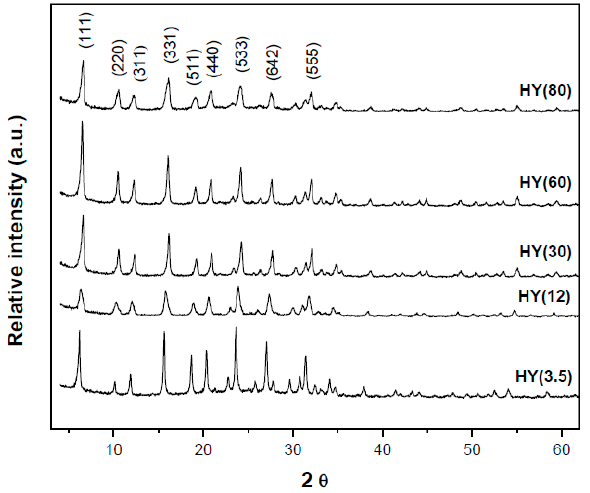
Figure 1. X-ray diffraction patterns of the HY zeolites.